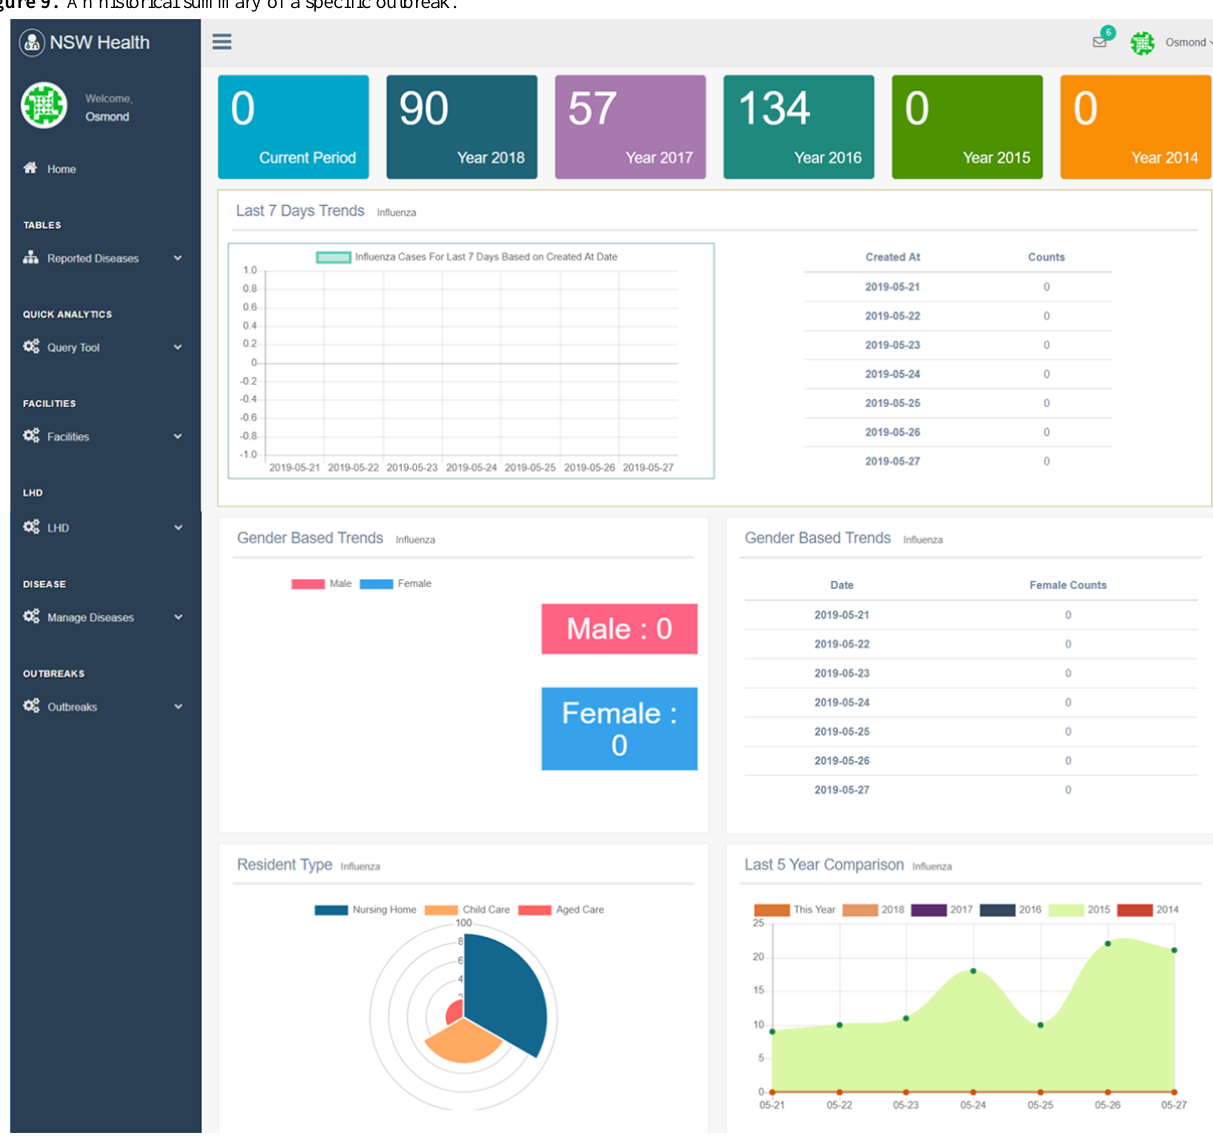
Figure 9. An historical summary of a specific